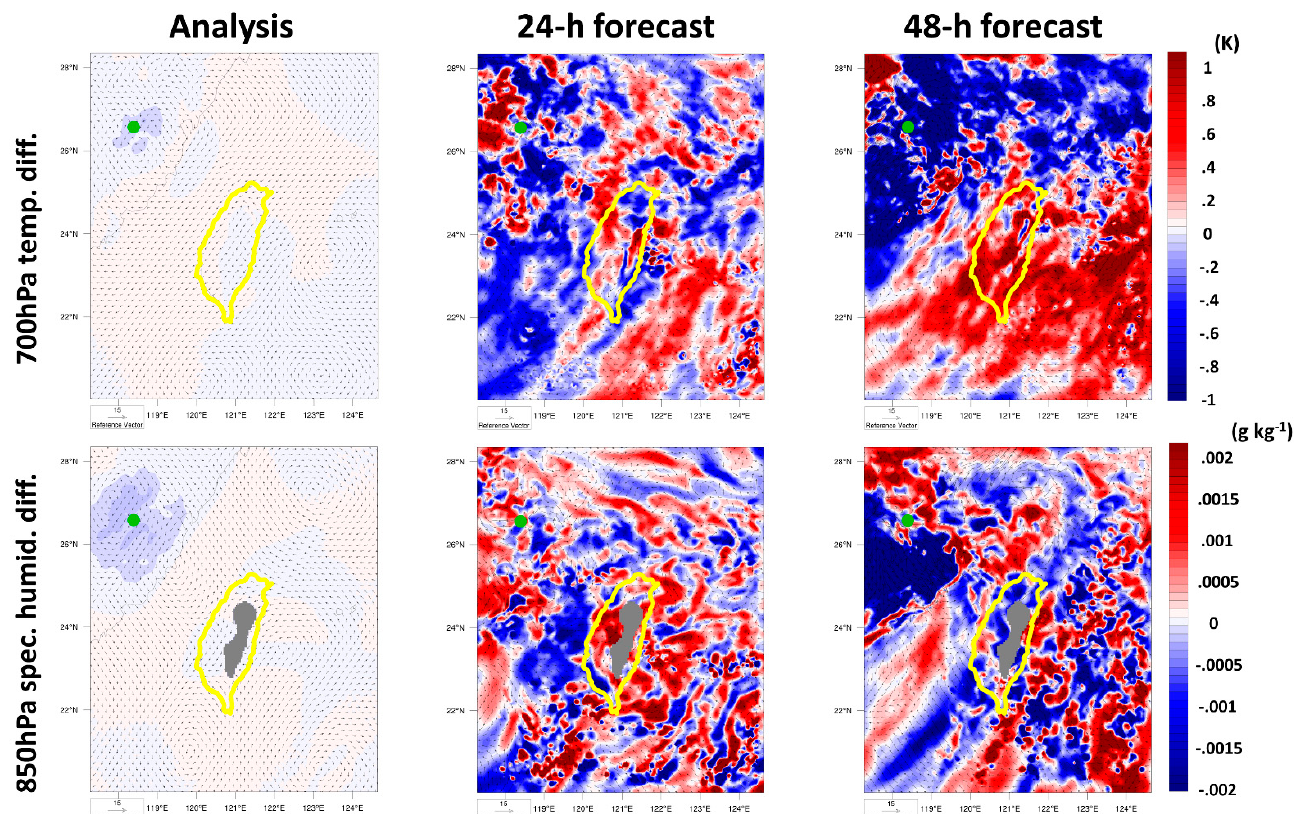
Figure 13. The (top) 700-hPa temperature and wind differences as well as (bottom) 850-hPa specific humidity and wind differences of WRF Member 2 minus WRF Member 1 at (from left to right) 0, 24, and 48 h for the forecast sample initialized at 12:00 UTC 6 June 2020. The color shading indicates the temperature and specific humidity differences. The arrows indicate the wind difference. The green dot denotes the COSMIC-2/FORMOSAT-7 RO observation assimilated by WRF Member 2. The gray shading indicates terrain.